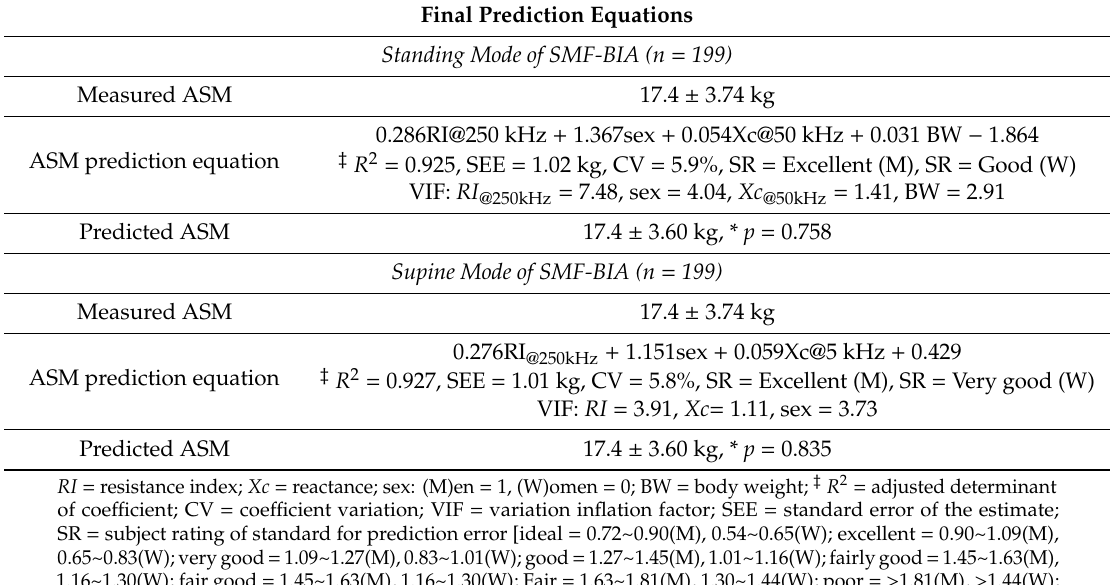
Table 3. The final predictive standing and supine BIA equations for ASM on Korean older